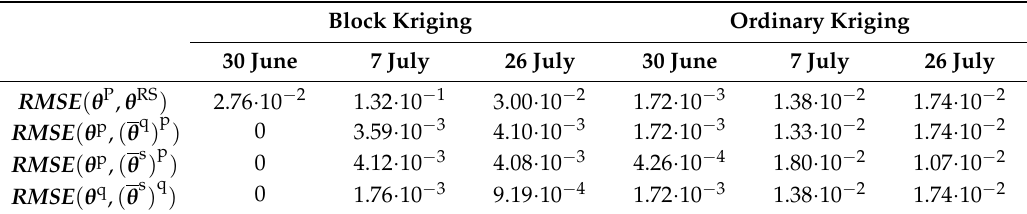
Table 8. Comparison of upscaled soil moisture estimations at the plot scale (p) against remote sensing (RS) data with RMSE; comparison of the upscaled soil moisture estimations of the larger scale pixels and the averaged value of the smaller scale pixel estimations within each larger scale pixel with RMSE for SoilNET and WaterNET merged data. Units are (m 3 · m − 3 ).